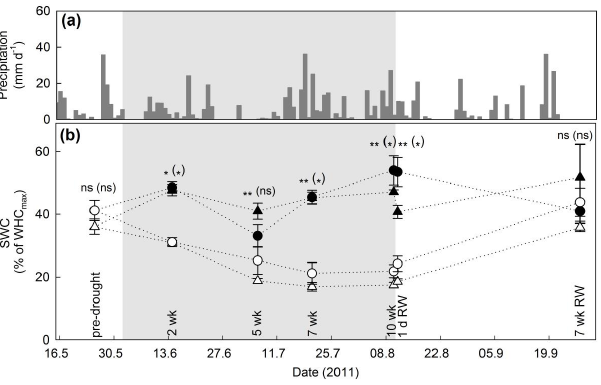
Figure 1. Precipitation (a) and soil water content ( b , SWC) cal- culated as percentage of the respective WHC max . Grey bars indi- cate precipitation (in mmd − 1 ). Filled symbols represent controls of the meadow (triangles) and abandoned site (circles), open sym- bols show the respective drought-treated plots (error bars indicate standard error, n = 4). Asterisks indicate differences between con- trols and drought treatments at single sampling points (levels of sig- nificance Bonferroni-corrected; ns, not significant; ∗ p < 0 . 05; ∗∗ p < 0 . 01, symbols without parentheses refer to the meadow; sym- bols in parentheses to the abandoned site). The period of drought treatment is marked as grey